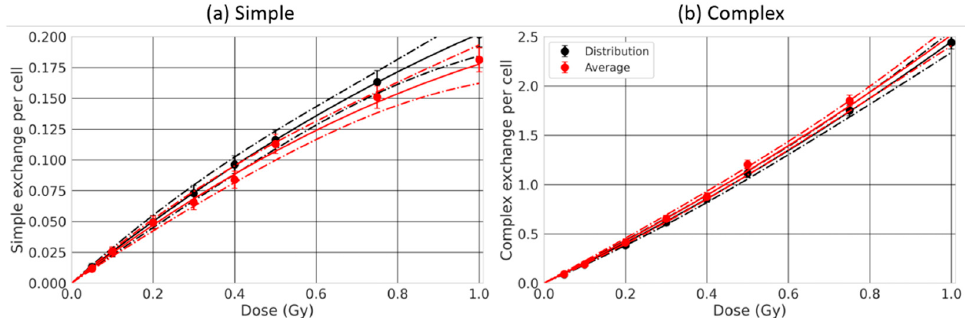
Figure 10. Simple ( a ) and complex ( b ) exchange dose-responses for a simulated irradiation by 170 MeV/n Si ion beam, considering a distribution of lymphocyte radii (black) or an average lymphocyte radius (red). The datapoints are results obtained by RITCARD, the solid line represents the best linear quadratic fit of the dose-response, and the dashed lines represent the 95% confidence interval.